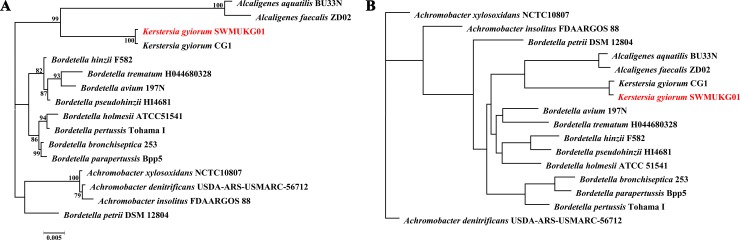
Phylogenetic trees of K. gyiorum SWMUKG01 and other closely related bacteria.(A) The phylogenetic tree was constructed using FastTree based on the 16S rRNA gene sequences. (B) The phylogenetic tree was constructed using PGAP based on 880 randomly concatenated, core genes in the genomes of K. gyiorum SWMUKG01 and 15 other closely related bacteria.